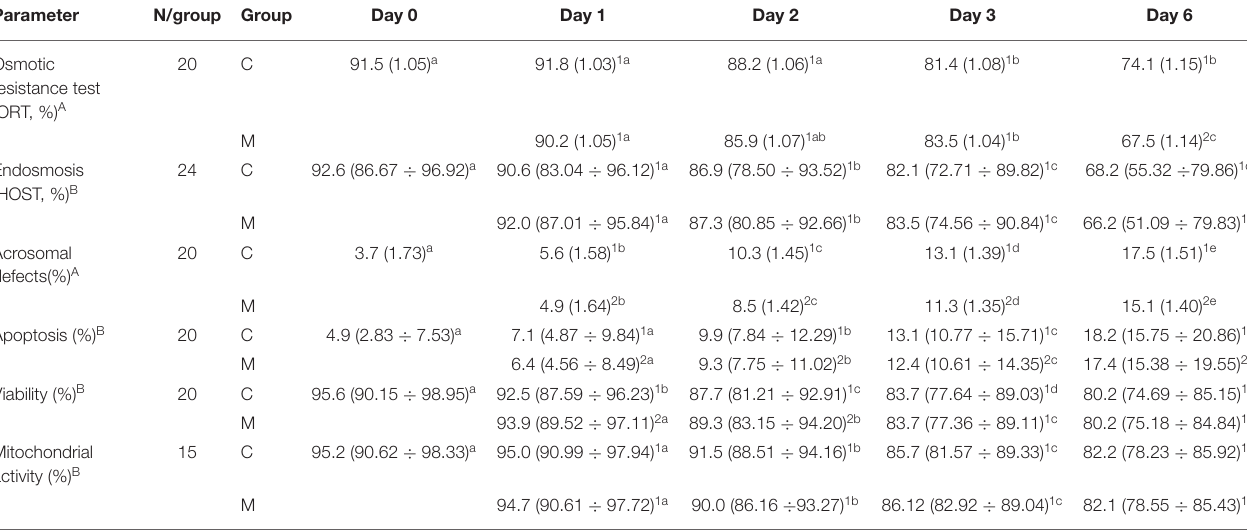
TABLE 2 | Results of semen analysis of osmotic resistance test (ORT), endosmosis (HOST), and flow cytometry parameters from semen samples collected in increasing photoperiod during a cold storage period of 6 days.